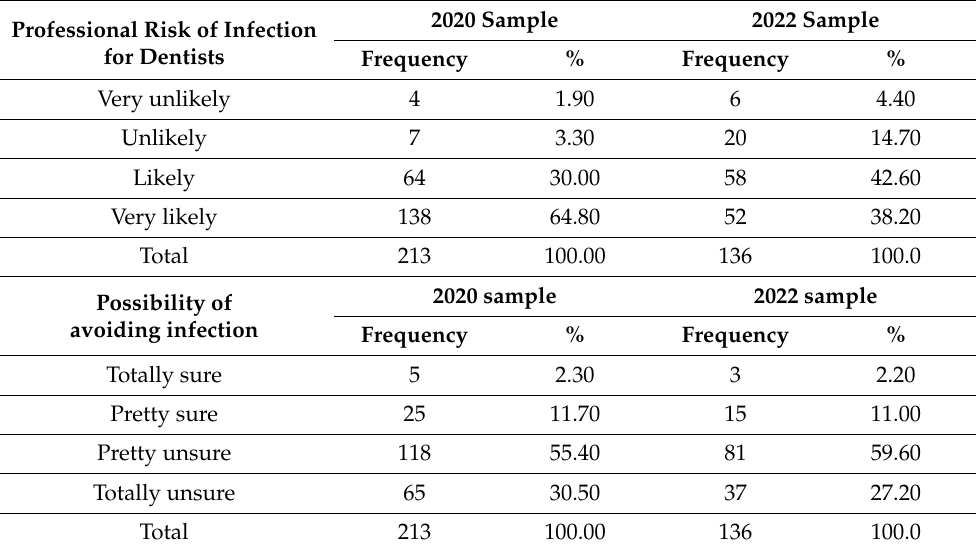
Table 7. Attitudes of the study participants toward the SARS-CoV-2 infection.